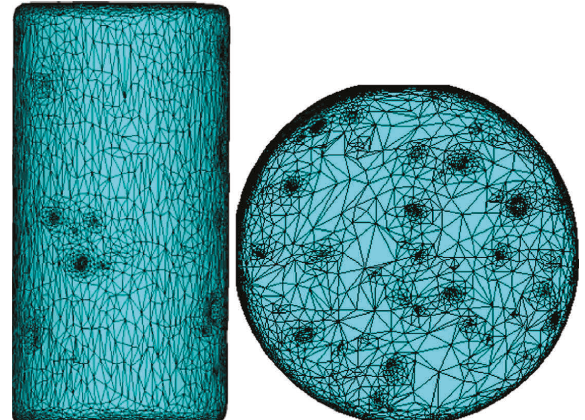
Figure 7: 3D FEM elements of concrete.